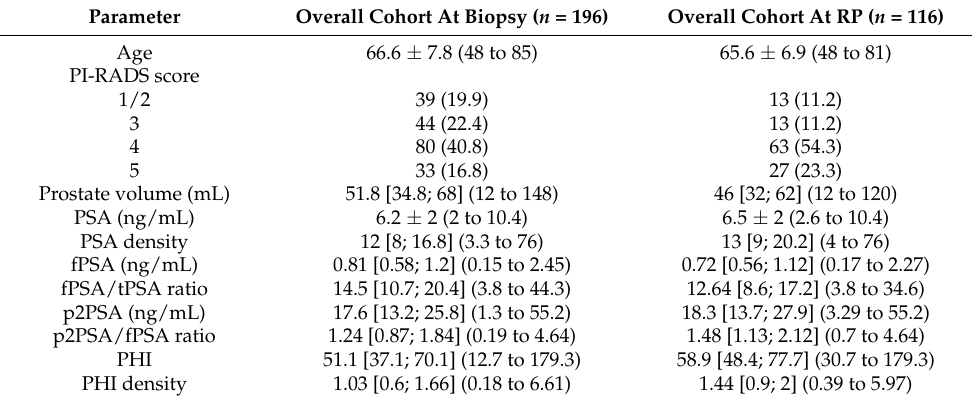
Table 1. Demographic and clinical characteristics of the study population. Data are reported as mean ± standard deviation (min to max), median [25th percentile; 75th percentile] (min to max) or absolute frequency